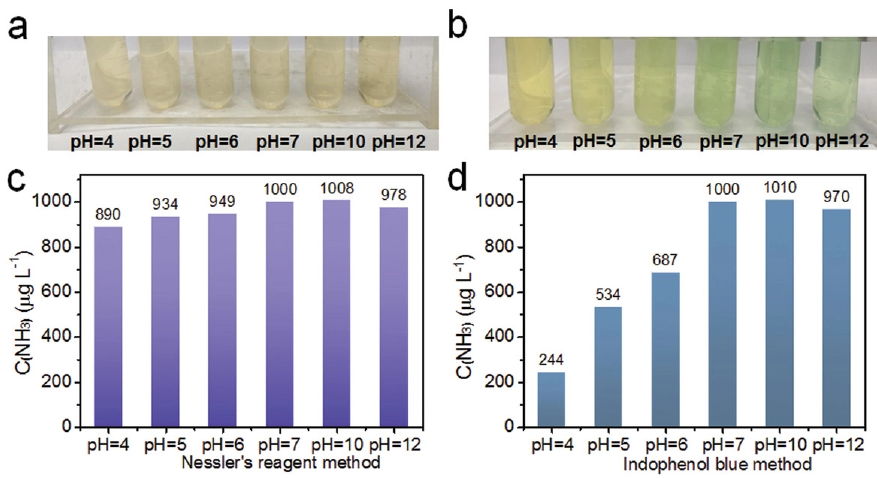
Figure 10. Ammonia concentration detection using ( a , c ) Nessler’s reagent and ( b , d ) indophenol blue at different pH. [Reprinted with permission from ref.